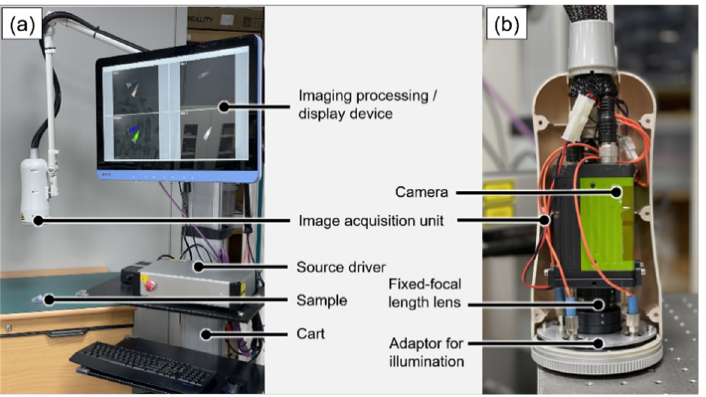
Figure 1. ( a ) Configuration of the proposed NIR fluorescence imaging system. ( b ) Image acquisition unit consisted of the single camera and the fixed-focal-length lens and adaptor for illumination parts.